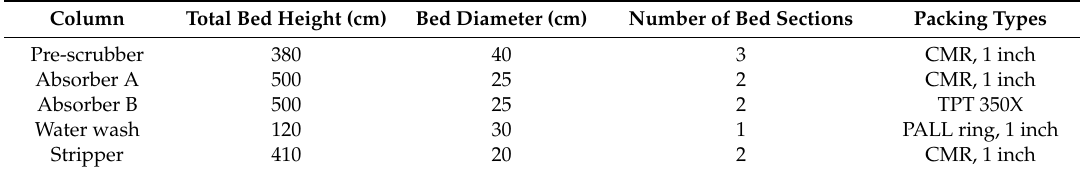
Table 4. Bed dimensions and packing materials of the packed columns in the PCCP.